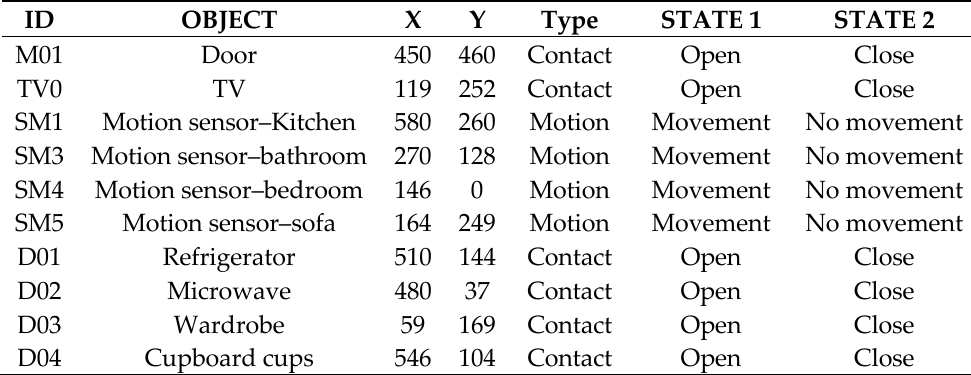
Table 2. Details of the binary sensors deployed in the UJAmI Smart